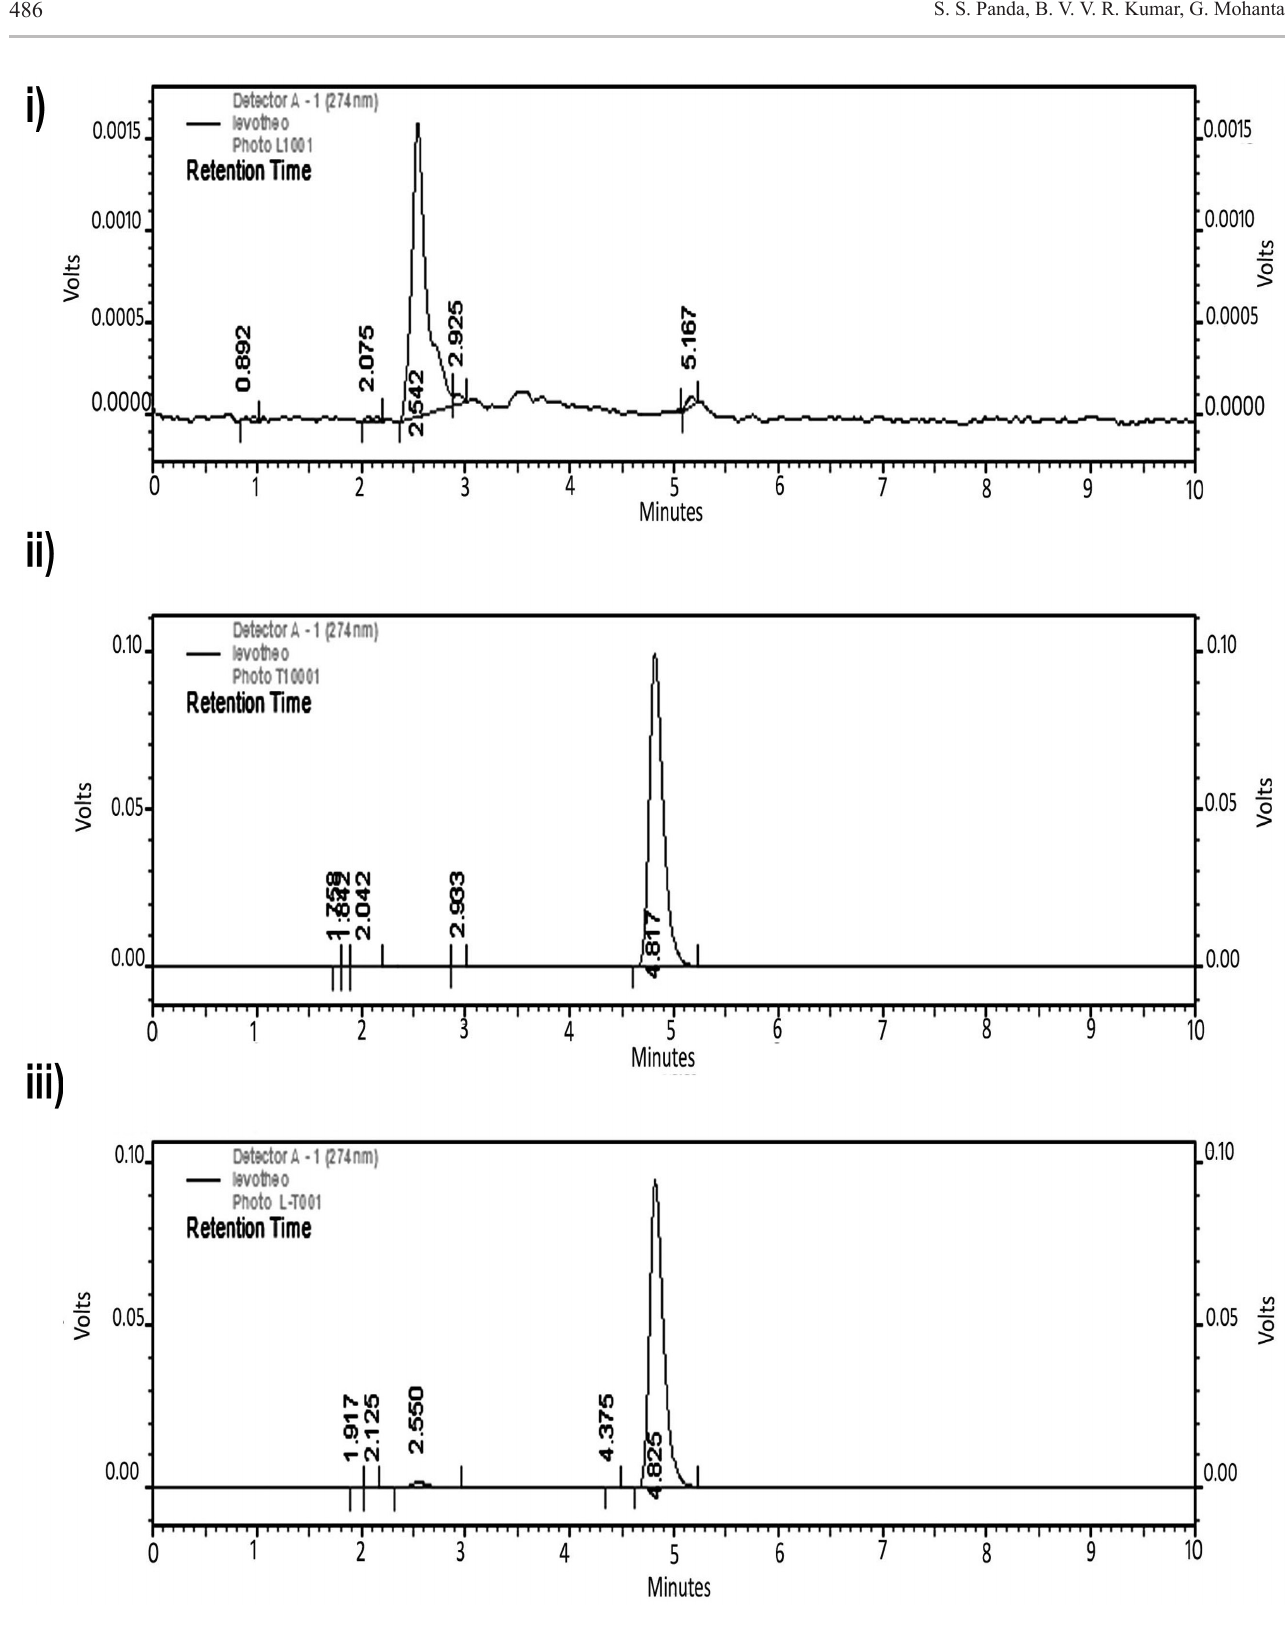
FIGURE 3F - Representative chromatograms of photolysed drugs. Each chromatogram represents (i) levosalbutamol sulfate (1 μg. mL -1 ), (ii) theophylline (10 μg. mL -1 ), (iii) dosage form having levosalbutamol sulfate (1 μg. mL -1 ) and theophylline (10 μg. mL -1